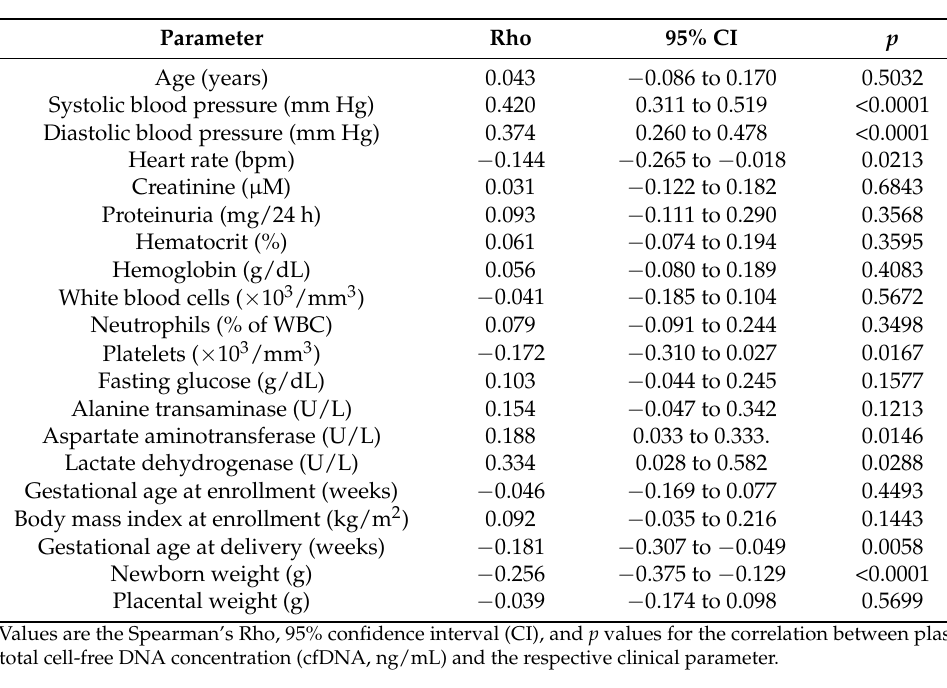
Table 2. Relationships between total cfDNA and clinical characteristics in all studied subjects.